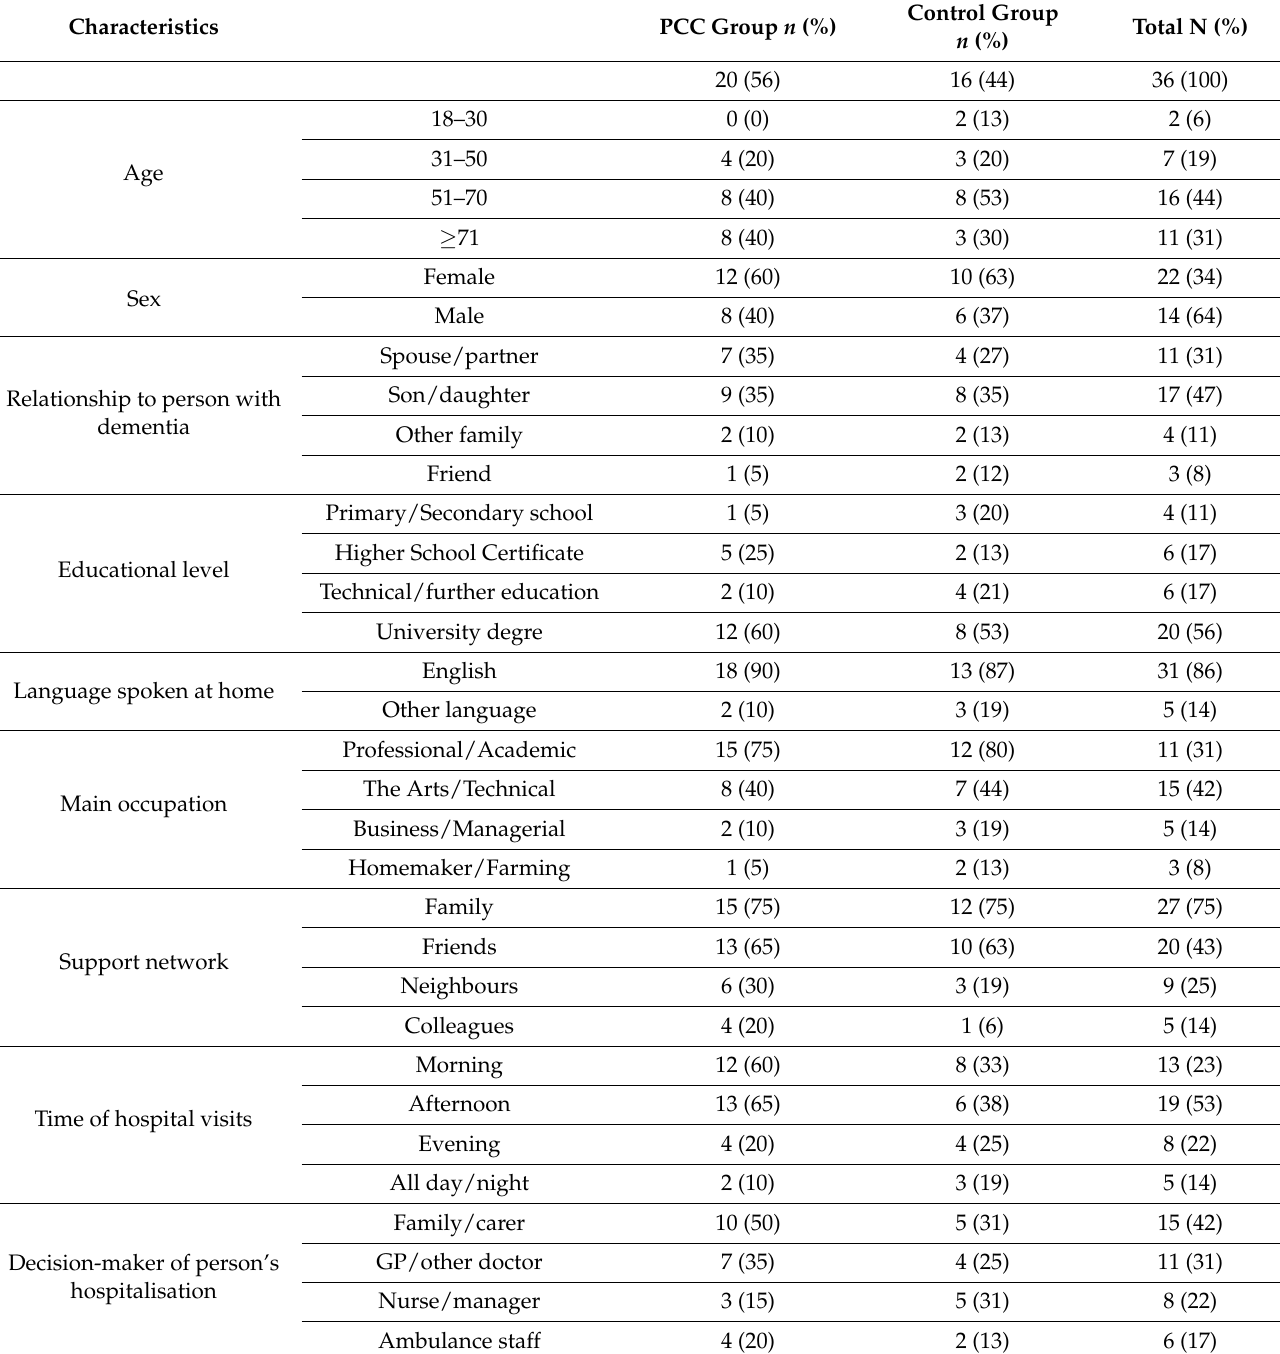
Table 3. Family/carer baseline characteristics ( n =